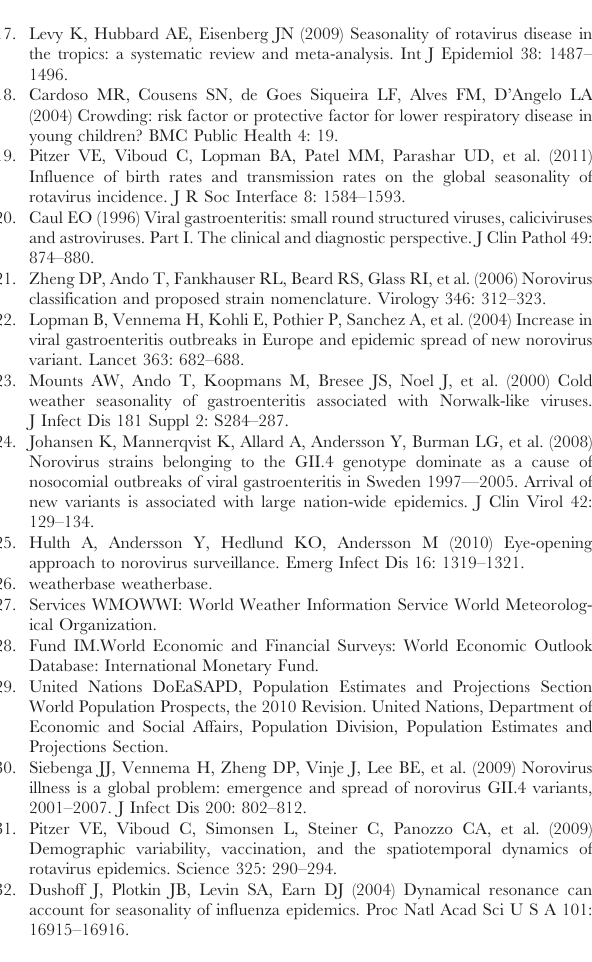
Table S1 Summary of Studies Included in